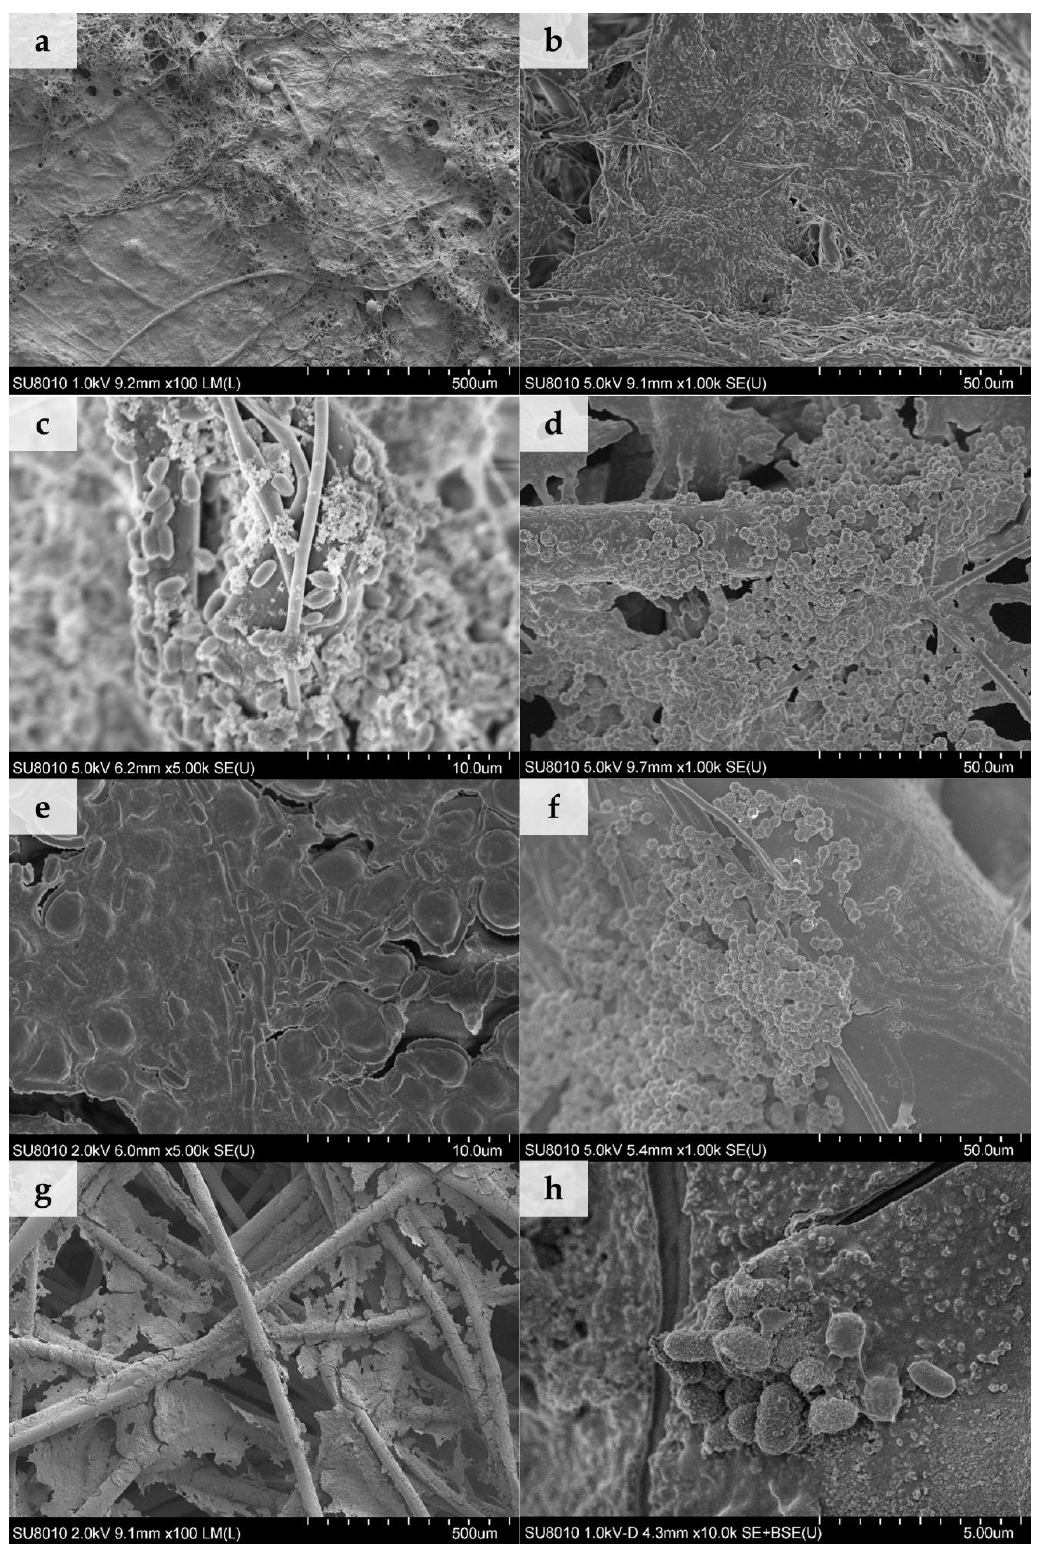
Figure 5. SEM images of biofilms on dust-loaded filtering nonwovens: ( a ) Control MB nonwoven, ( b ) MB with dust A, ( c ) MB with dust B, ( d ) control SB nonwoven, ( e ) SB with dust A, ( f ) control NP nonwoven, ( g ) NP with dust A, and ( h ) NP with dust B.